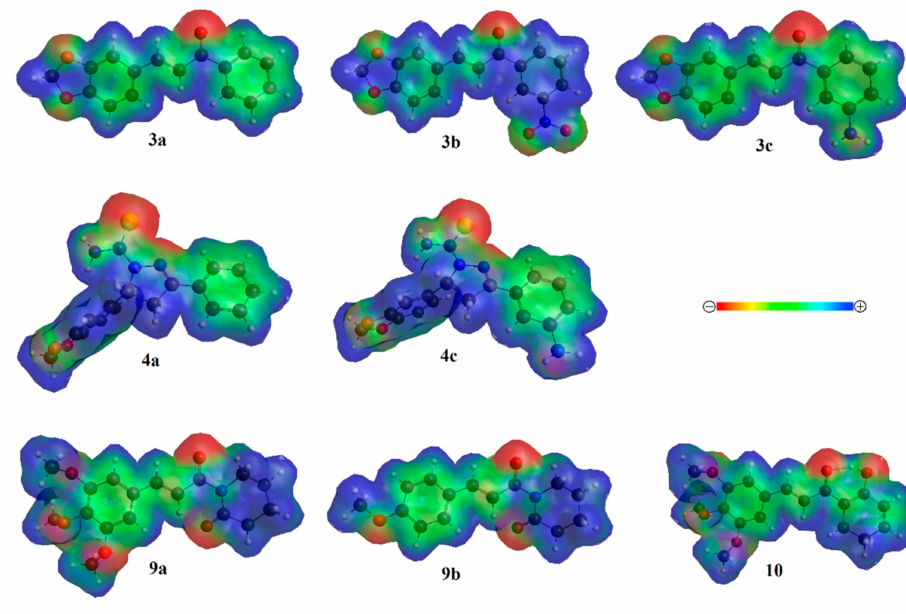
Figure 1. Map of electronic potential (MEP) of piperine and PPL-inspired molecules, where the scale is from negative density charge (represented by red) to positive density charge (represented by